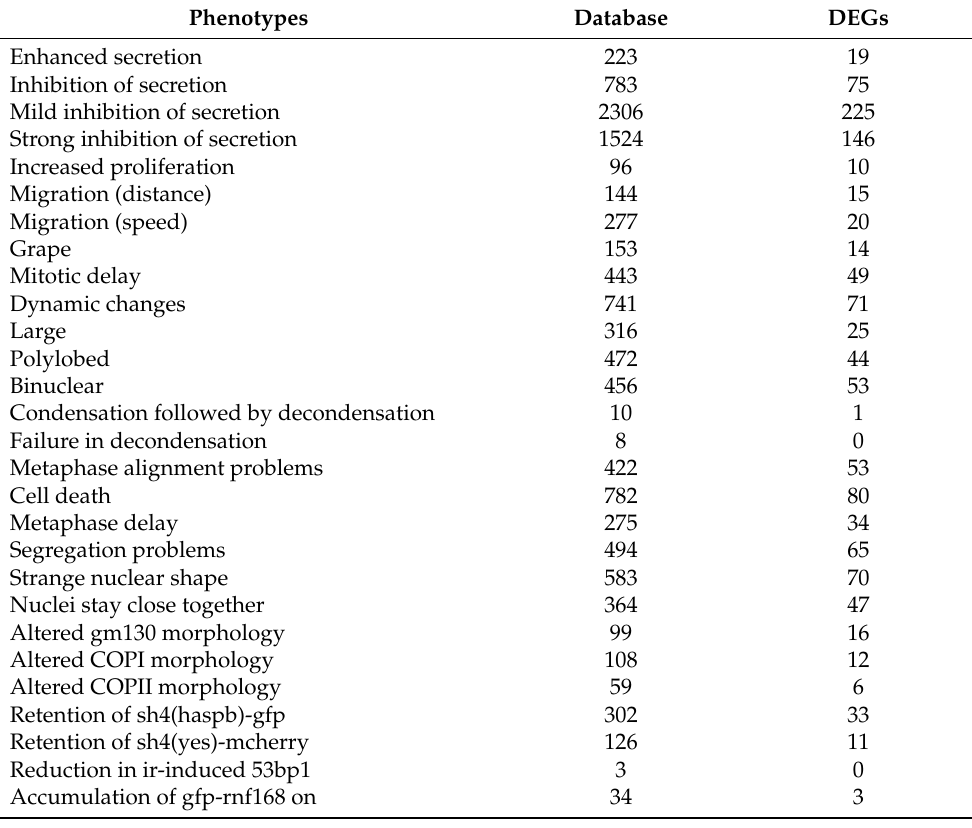
Table 4. Classification of DEGs based on their phenotypic effects using the Mitocheck database.